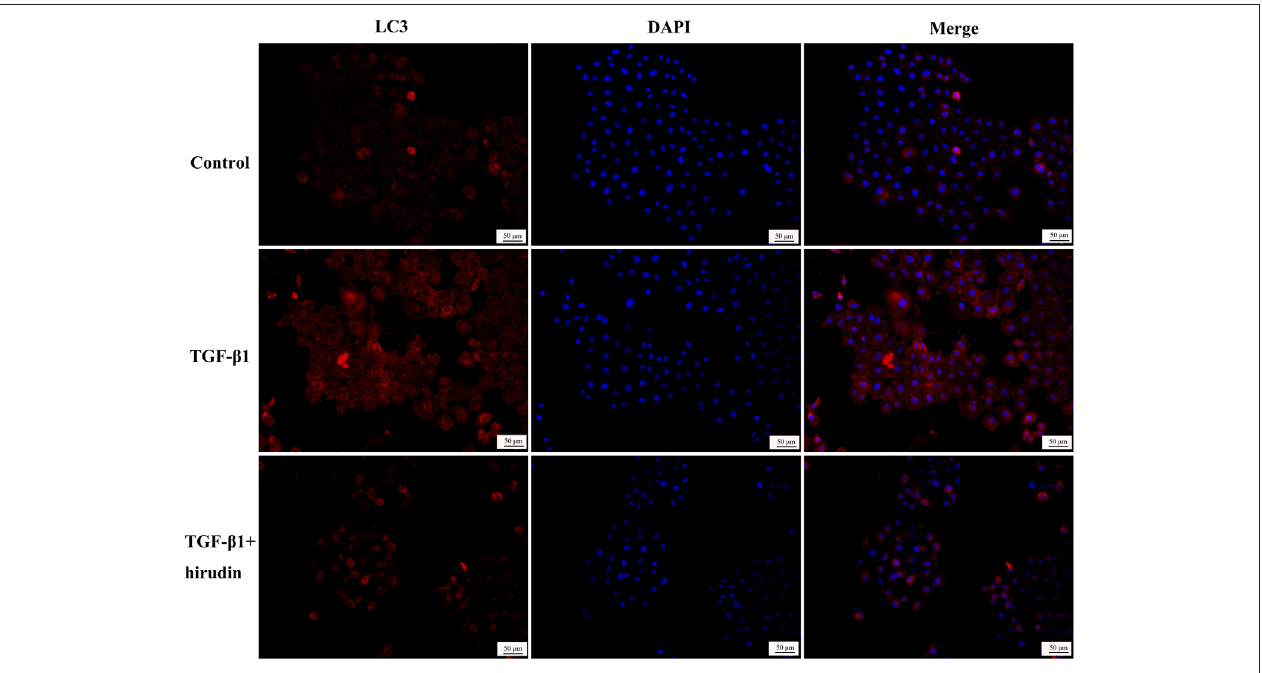
FIGURE 8 | Cellular immuno fl uorescence detection of LC3 protein expression.